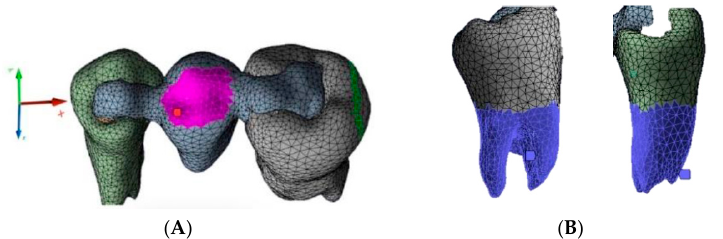
Figure 5. Discrete model and boundary conditions of the analyzed model: ( A ) loads (the purple area); ( B ) fixed support (the blue area).